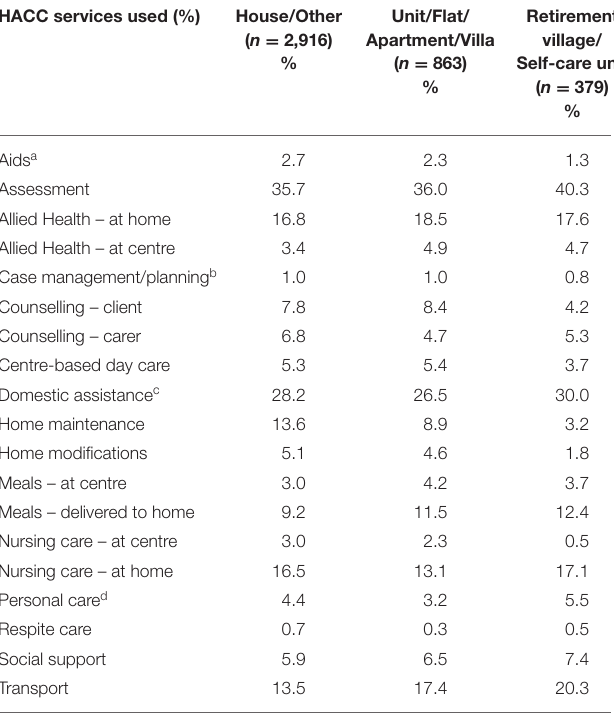
TABLE 3 | Effect of housing and other factors on the use of HACC services over time among older Australian women. Adjusted for period only